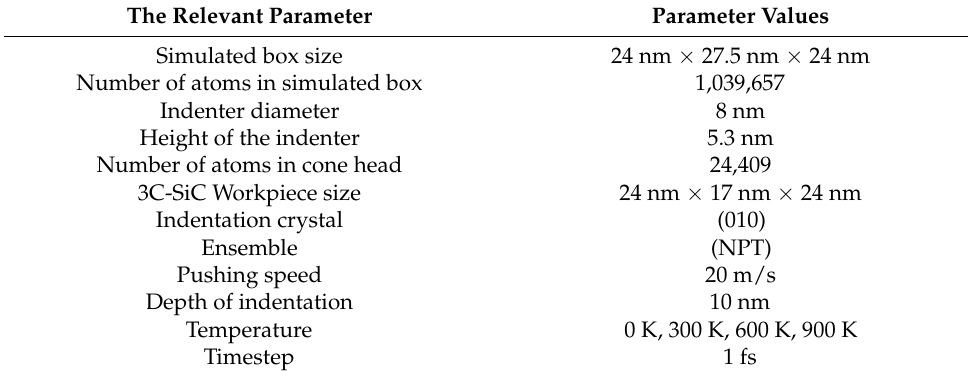
Figure 1. Nanoindentation single crystal 3C-SiC model diagram. Table 1. Model parameters of 3C-SiC